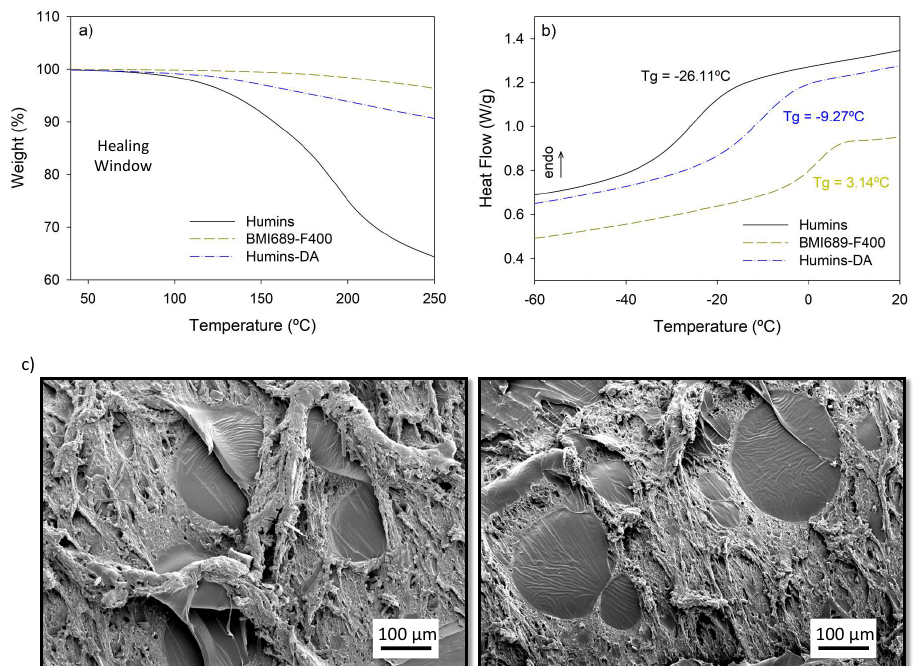
Figure 2. ( a ) TGA results of humins (black), BMI689-F400 (dark yellow) and Humins-DA blend (blue) at 5 K·min −1 , ( b ) DSC analysis of humins (black), BMI689-F400 (dark yellow) and Humins-DA (blue). Samples were cooled to −80 °C at 5 K·min −1 and re-heated at 5 K·min −1 , ( c ) SEM pictures of the Humins-DA cross-section.